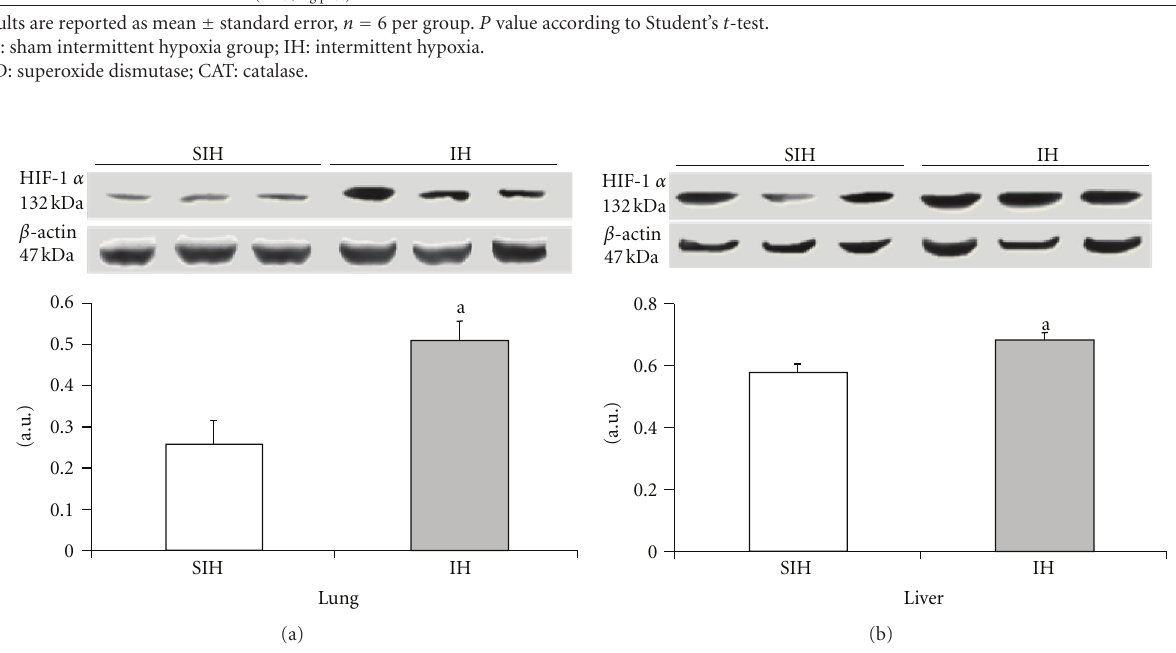
Figure 2: The e ff ect of intermittent hypoxia on the expression of HIF-1 α in the liver ((a), P = 0 . 0227) and lung ((b), P = 0 . 0086). Results are reported as mean ± standard error, n = 6 per group. P value according to Student’s t -test.